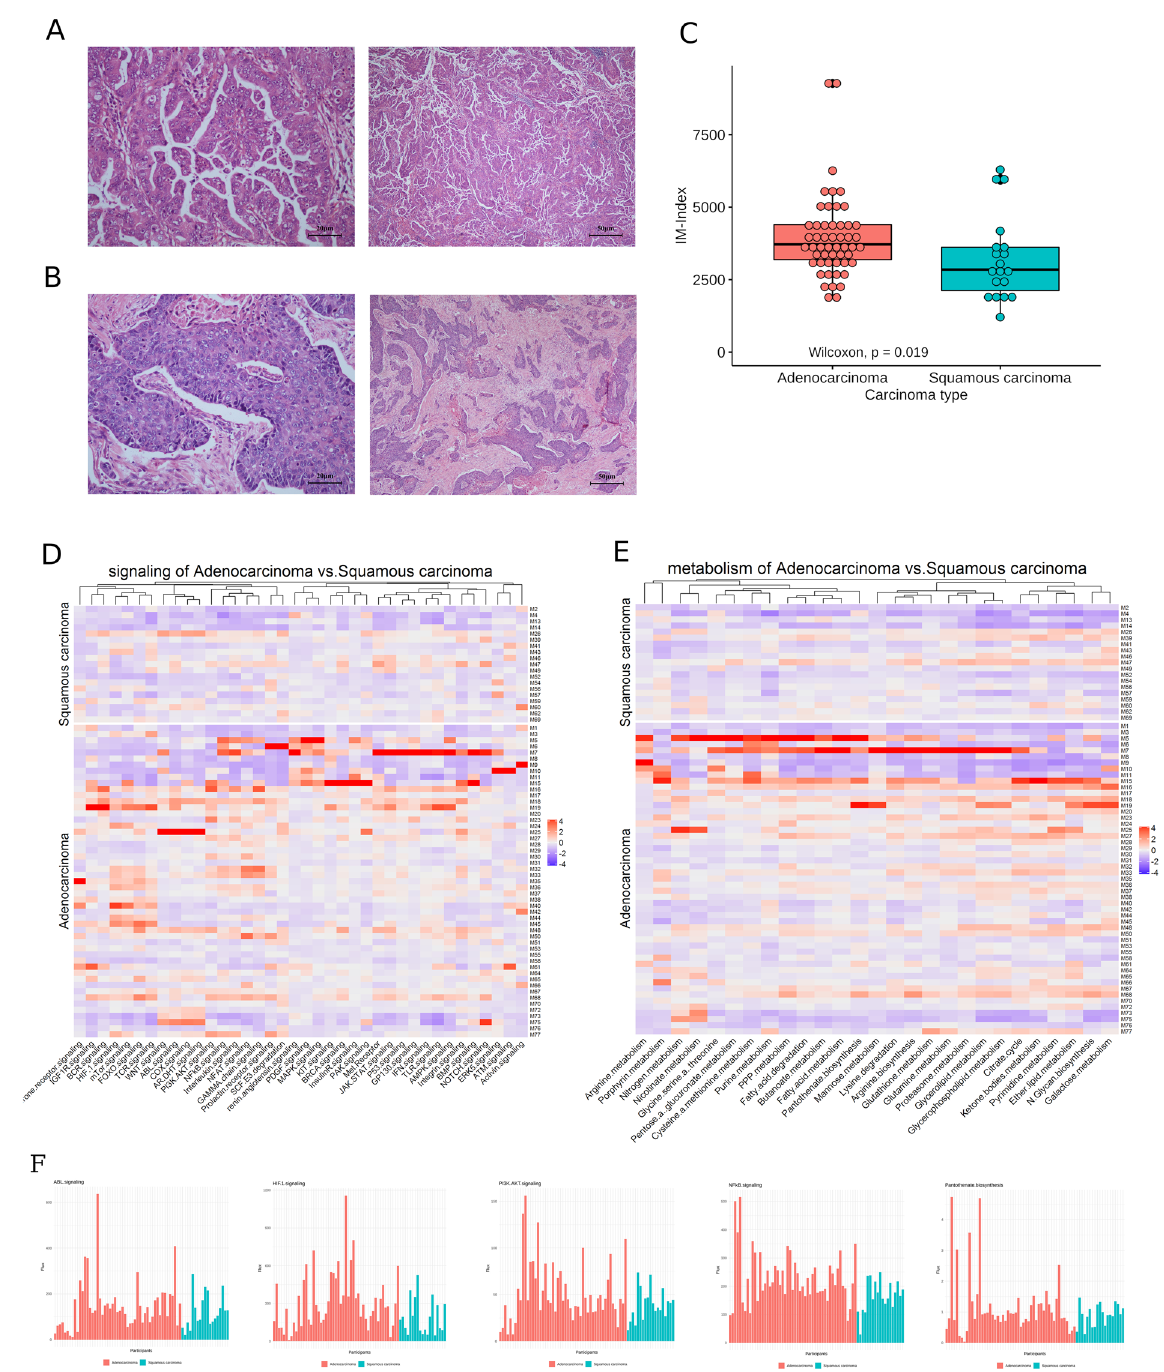
Figure 4. Histopathology of adenocarcinoma and squamous carcinoma tissues and differentiation between both sub-groups. ( A ) Haematoxylin and eosin (H&E) stained tissue sample of a participant (M11) showing adencarcinoma tissue at the center (left) and widespread malignancy (right) ( B ) H&E stained tissue sample of a participant (M43) showing squamous carcinoma at the center (left) and at the margin (right). ( C ) Boxplot of the immune-related index (IM-Index) for adenocarcinoma (red) and squamous carcinoma sub-groups (cyan). The p -value obtained through the Wilcoxon test showed statistical significance with p = 0.019. ( D , E ) Heatmap of the differentiated activities (fluxes) of signaling- and metabolic pathways for both sub-groups. ( F ) five differentiated signaling pathways between adenocarcinoma and squamous carcinoma